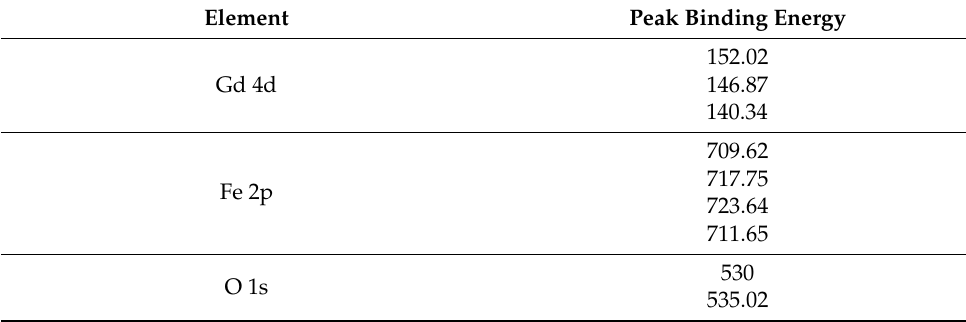
Table 2. XPS spectra of gadolinium orthoferrite annealed at 800 ◦ C.